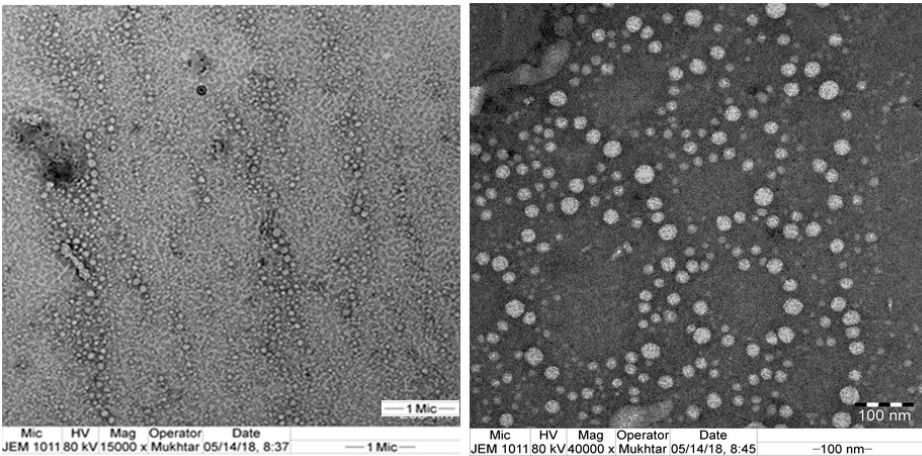
Figure 3. Photomicrographs of the optimized FBX-SNEDS by TEM image.